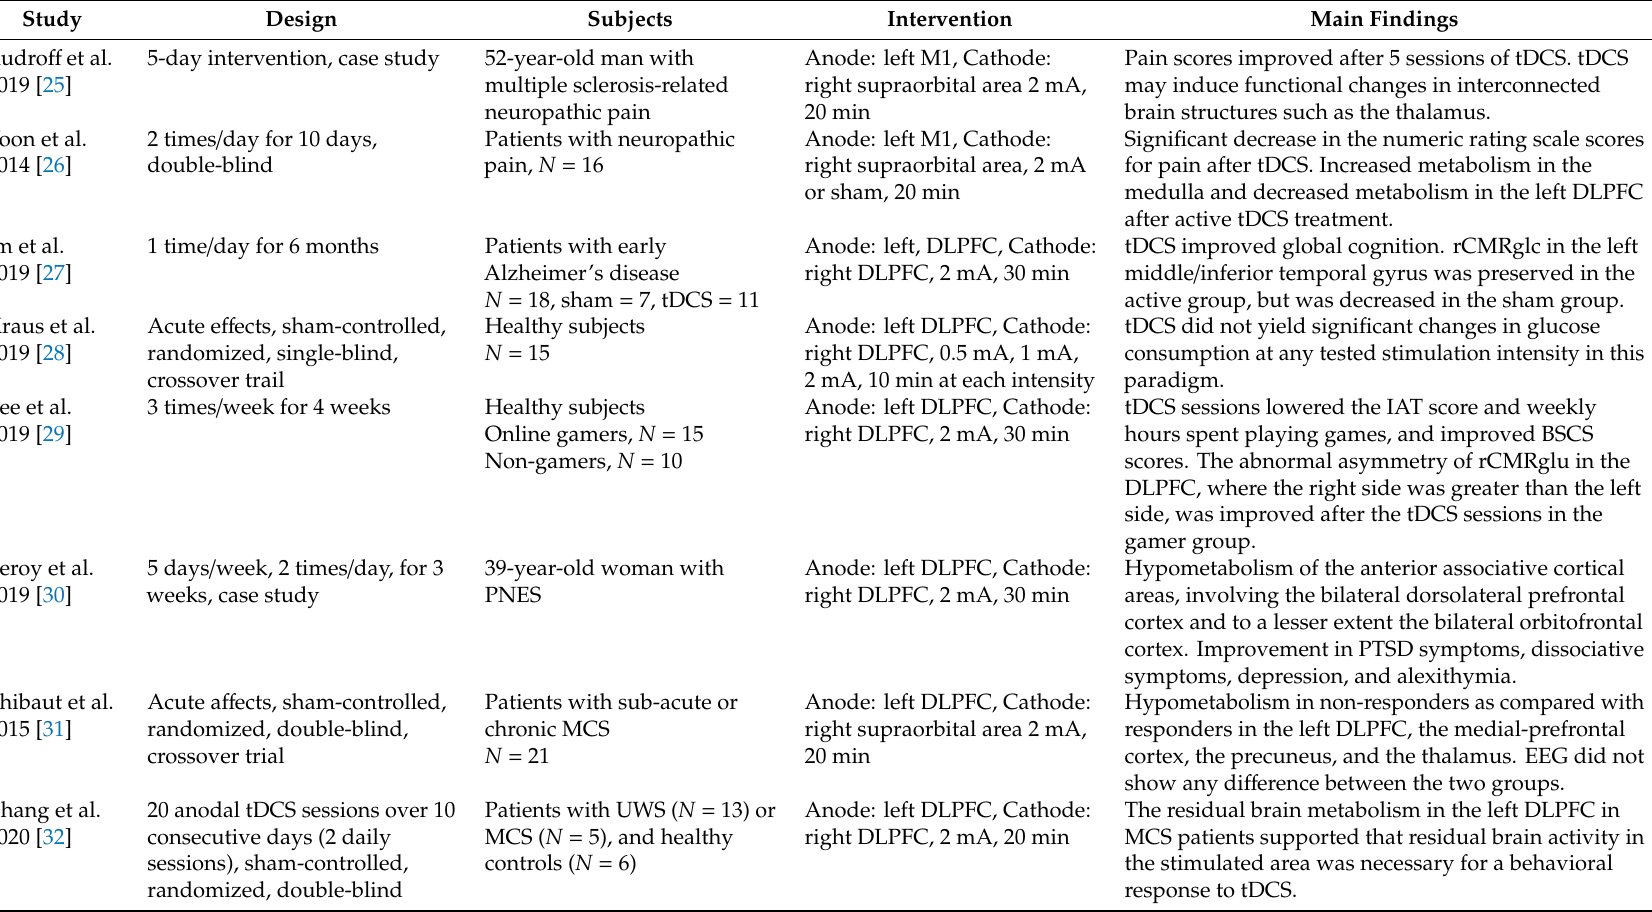
Table 1. Summary of studies that investigated the e ff ects of transcranial direct current stimulation (tDCS) with FDG-PET.